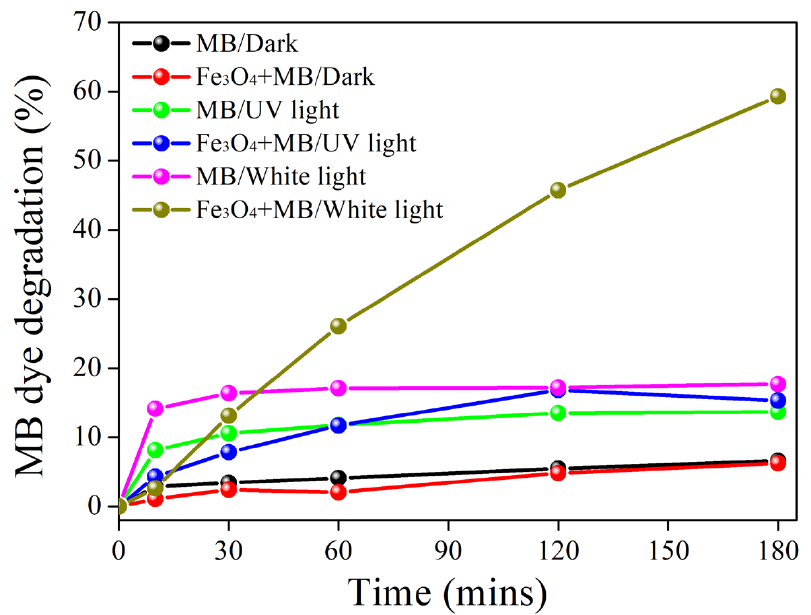
Figure 7. The MB degradation efficiency under different levels of environment and light irradiation.